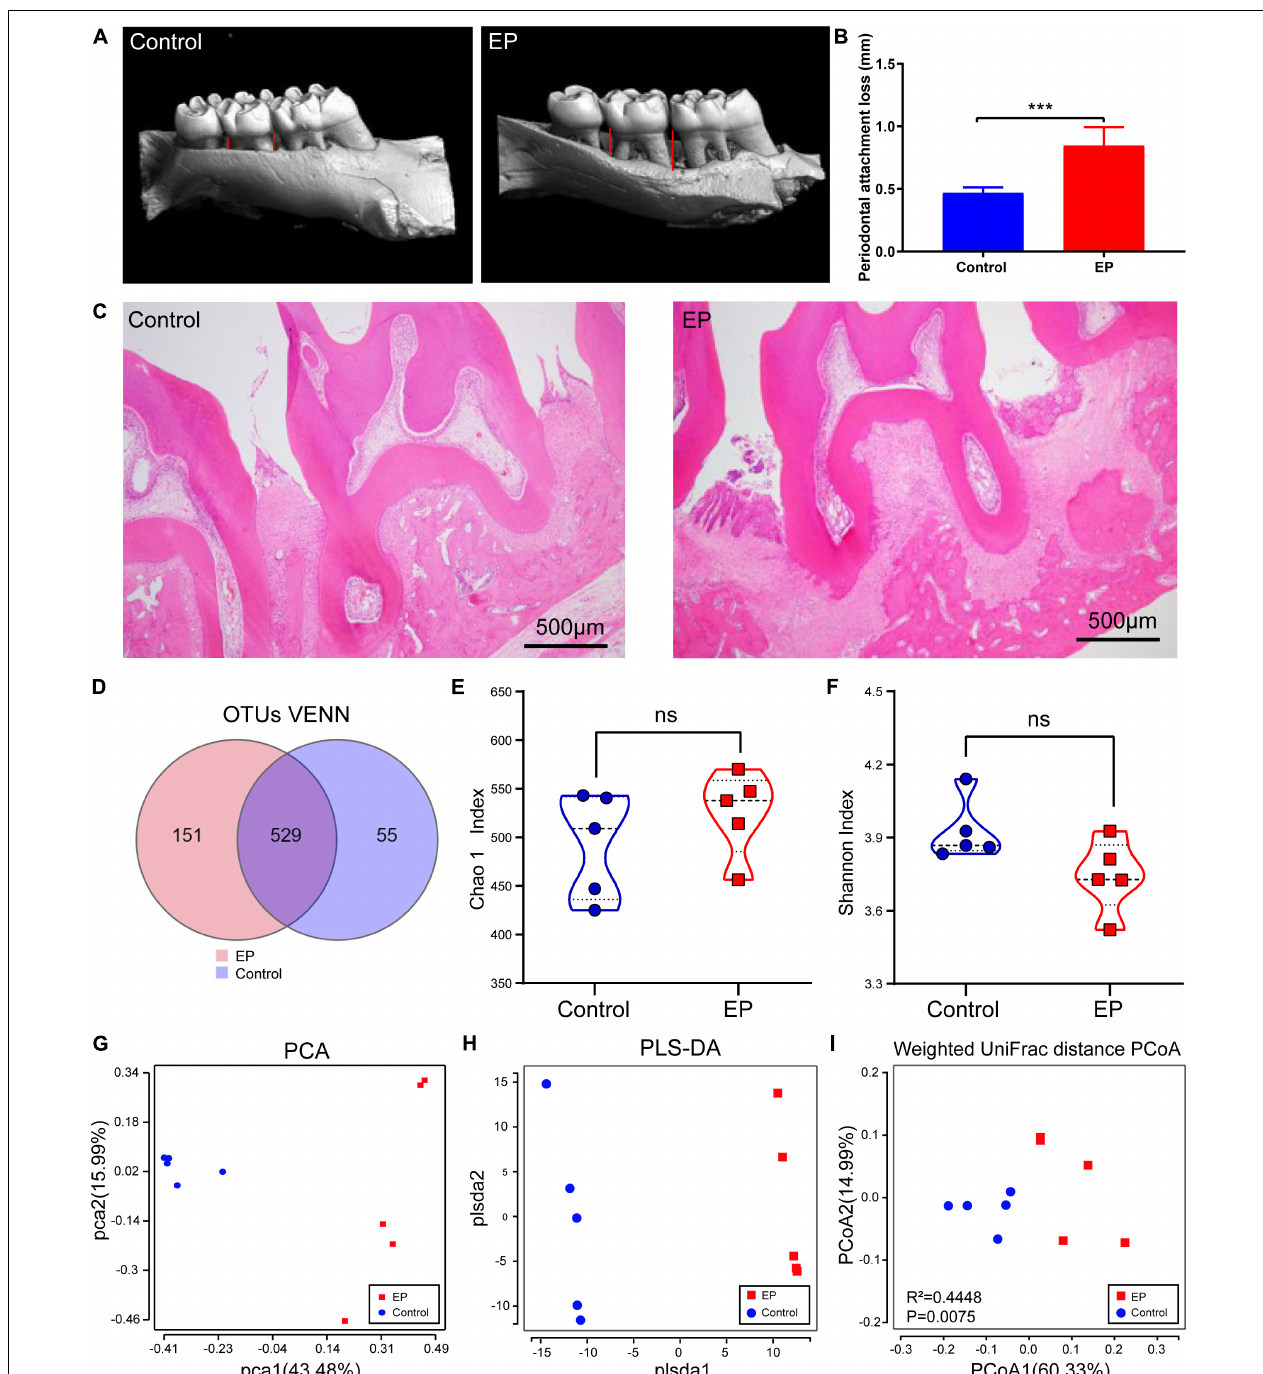
FIGURE 1 | Detection of periodontal tissue in rats and diversity analysis of gut microbiota. (A) Representative 3D reconstruction images of alveolar bone by micro-CT. (B) Histogram of statistical analysis of periodontal attachment. (C) Representative figures from H and E staining for the second molar. (D) Shared and unique OTUs in the gut microbiome in EP and control group. Chao 1 index (E) and Shannon index (F) of the two groups. Principal component analysis (PCA) analysis (G) , partial least-squares method–discriminant analysis (PLS–DA) (H) , and Principal Coordinate Analysis (PCoA) based on Weighted Unifrac distance matrix (I) of EP and Control group. EP, experimental periodontitis group; Control, healthy control group. *** p < 0.001; ns, no